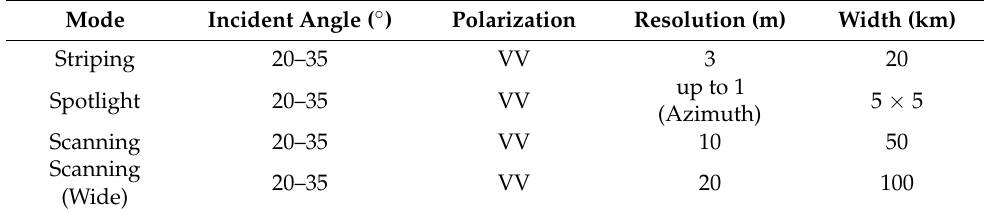
Table 1. Main Parameters of